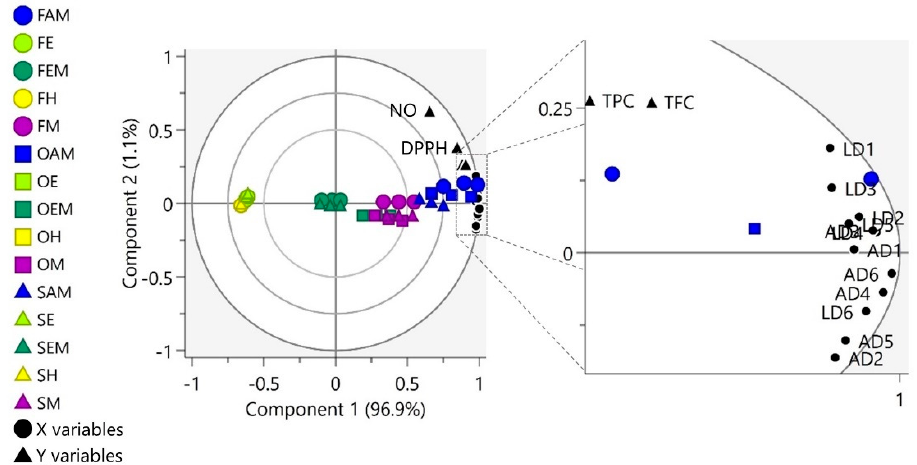
Figure 3. Biplot of the partial least square (PLS) model exhibiting correlation between relatively quantified luteolin and apigenin derivatives and antioxidant activity of OPL extracts obtained from various drying methods and extraction solvent systems. The ellipses (innermost to outermost) represent correlation-scaled loadings of values 0.50, 0.75, and 1.00, respectively. Abbreviations: F,